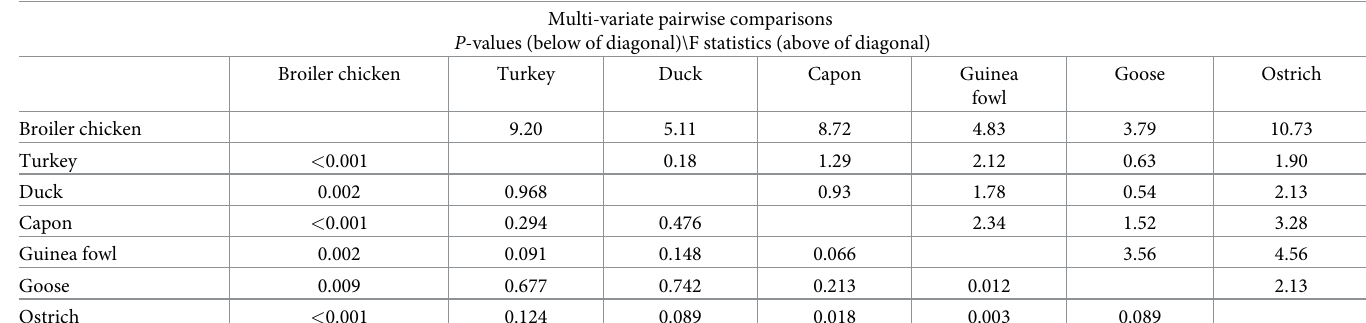
MANOVA: F = 2.94, P < 0.001 Multi-variate pairwise comparisons